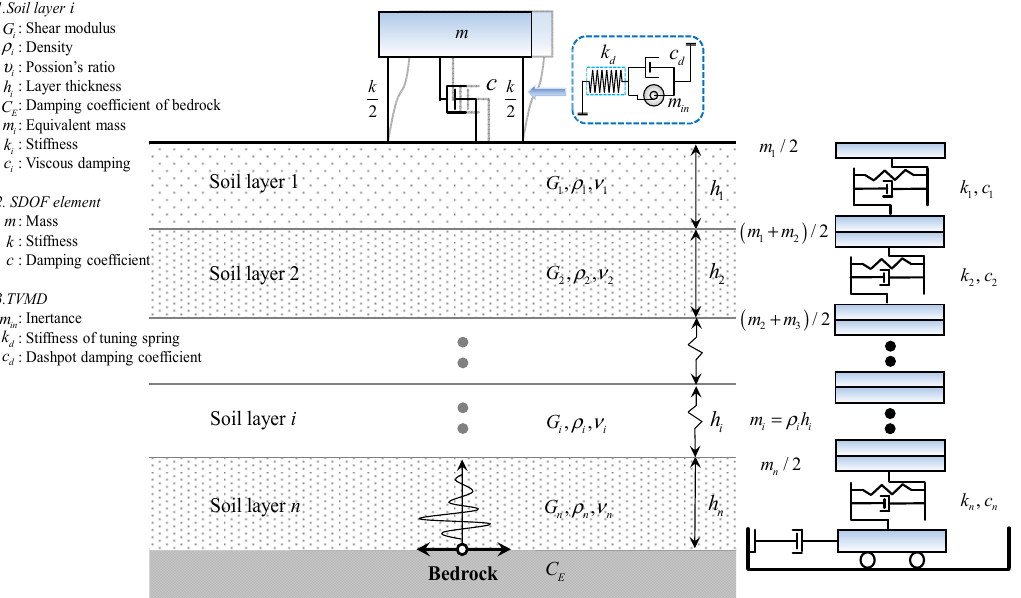
Figure 1. Lumped parameter model representation of a horizontally layered soil deposit and the aboveground structure.